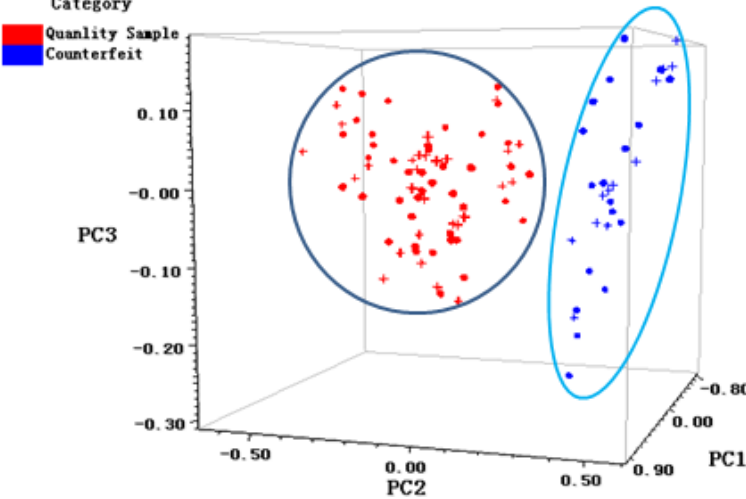
Fig. 5. Plot of PCA scores (PC1 vs PC2 vs PC3) of samples (red dot represents the authentic sample, and blue dot represents the fake sample). Circular dot represents the calibration set sample, and crossed dot represents the validation set